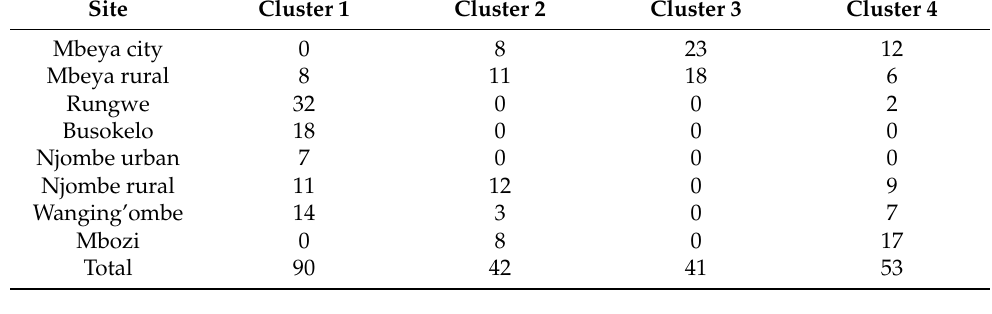
Table 3. Information on the number of samples in each cluster.